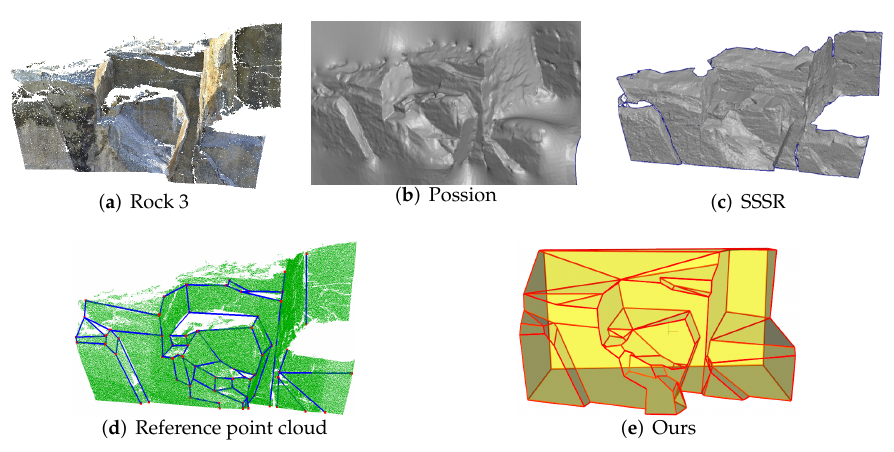
Figure 15. Reconstruction results of Rock 5.